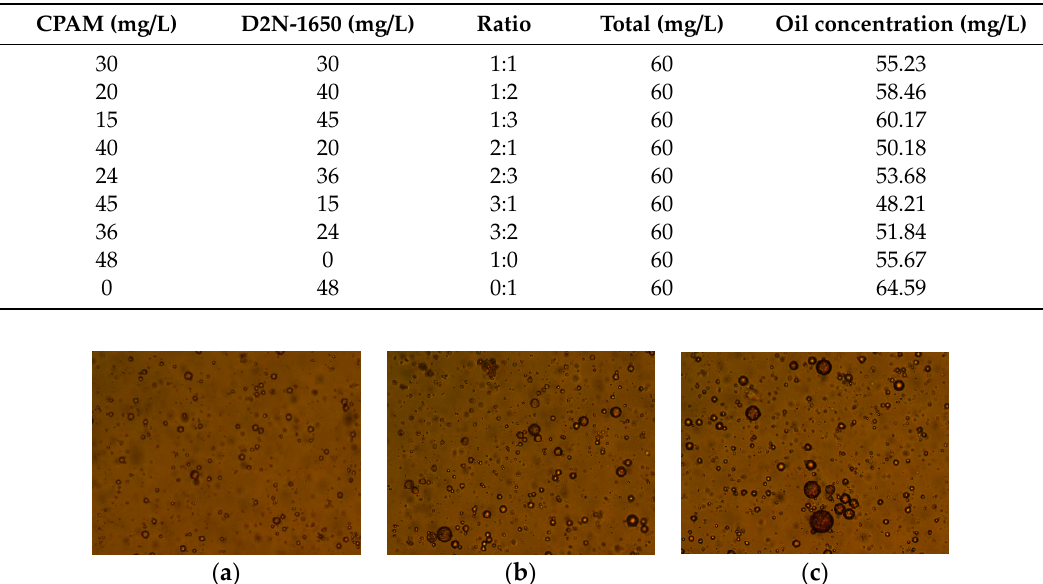
Figure 5. Effect of SW flocculant on oil droplets. ( a ) At 0 h settling with no SW flocculant; ( b ) At 4 h settling with no SW flocculant; ( c ) At 4 h settling with SW flocculant.